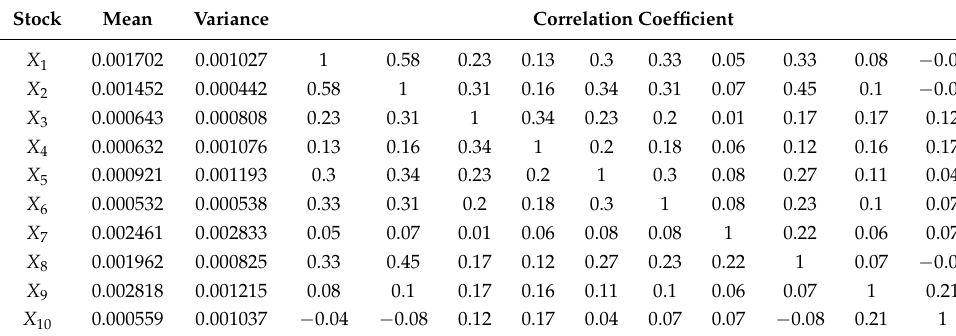
Table 2. Means, variance, and correlation coefficients of stock